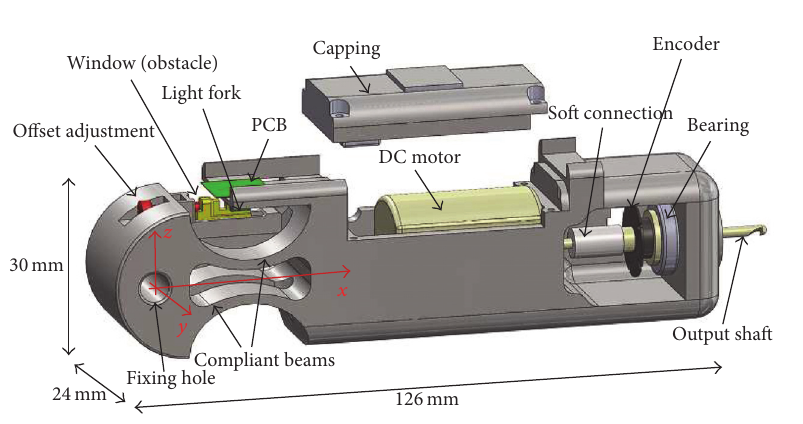
Figure 4: Detailed view of the twisted string actuation module.